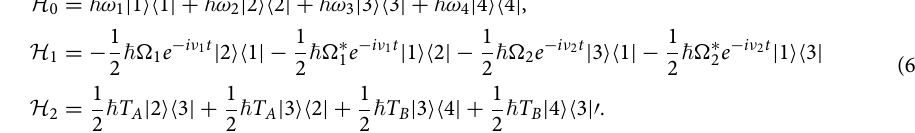
and the transverse view of LG beam intensity is